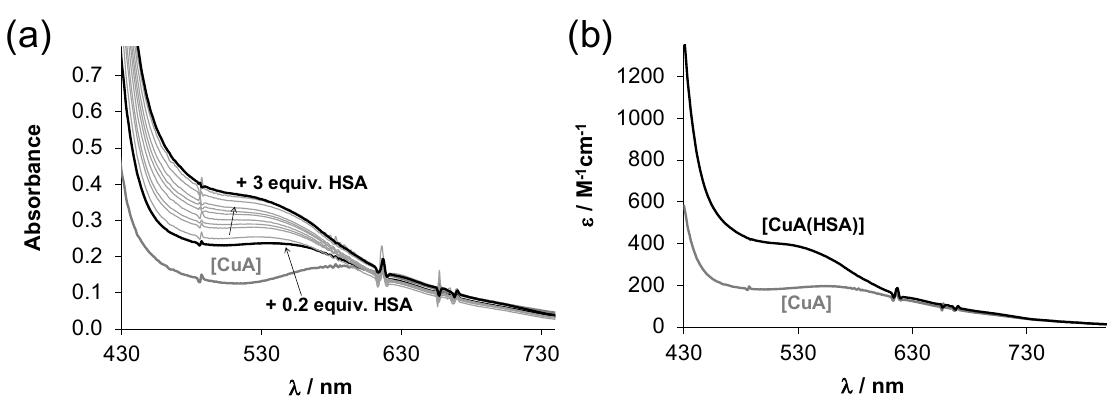
Figure 5. ( a ) Visible spectra recorded for the copper(II) ‒ STSC ‒ HSA system at pH 7.4 after 4 h equilibration time in the wavelength range of the d-d bands at various equivalents of HSA and b ) the calculated molar absorbance spectra of the binary STSC [CuA], and the ternary [CuA(HSA)] complex. {30% ( w / w ) DMSO/H 2 O; pH = 7.4 (20 mM HEPES); T = 25 °C; I = 0.10 M (KCl); c Cu(II) = c TSC = 200 μM, c HSA = 0–600 μM; ℓ = 5 cm}.